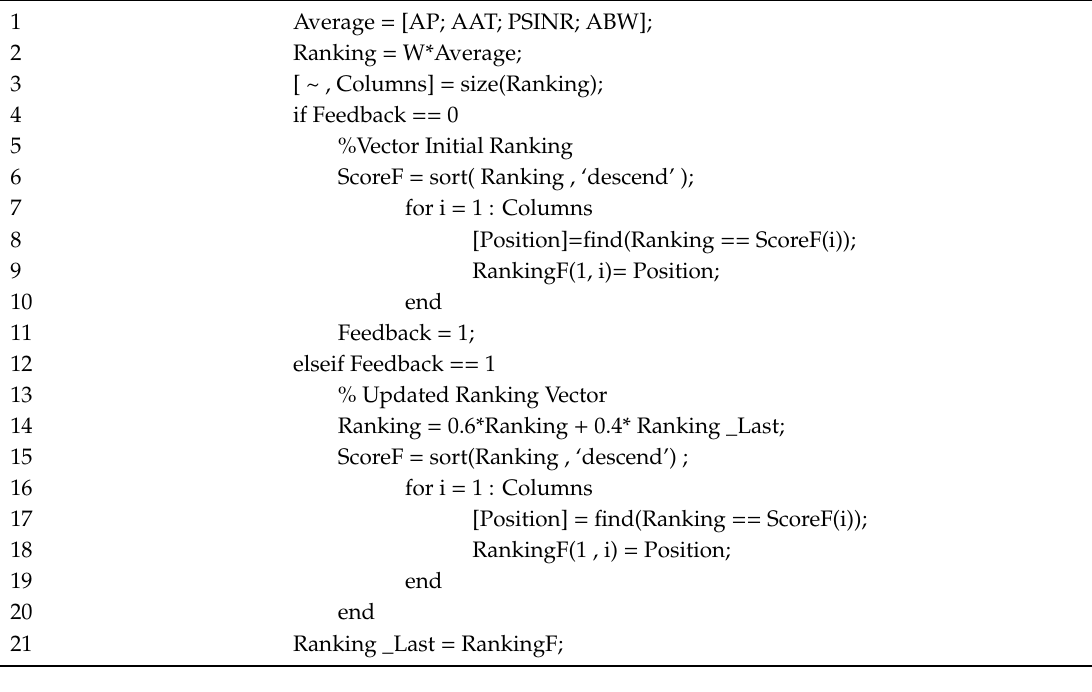
Algorithm 1 : MATLAB implementation Feedback Fuzzy Analytical Hierarchical Process (FFAHP).